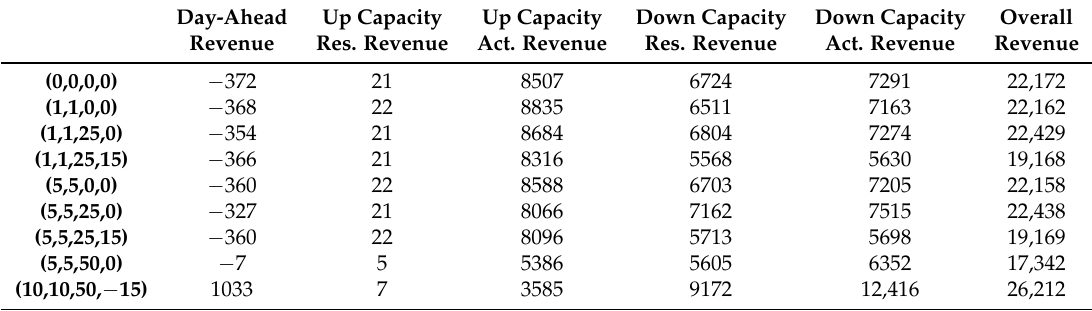
Table 5. Effect of the bidding parameters on the battery storage profit (in e ); the four numbers in the top cells indicate (i) up capacity reservation price ( e /MW), (ii) down capacity reservation price ( e /MW), (iii) up capacity activation price ( e /MWh), (iv) down capacity activation price ( e